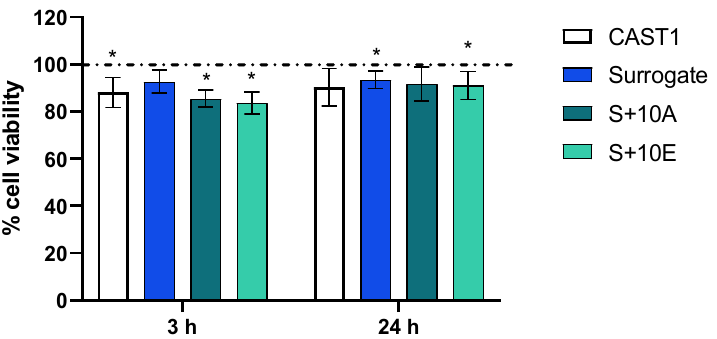
10 of 17 Figure 3. Oxidative potential of particles from CAST1, Surrogate, S+10A, and S+10E by DTT assay ( A ) and AA depletion measurement ( B ). 3.3. Cell Response after Exposure BEAS-2B cells were exposed to CAST1, Surrogate, S+10A, and S+10E emissions for 35